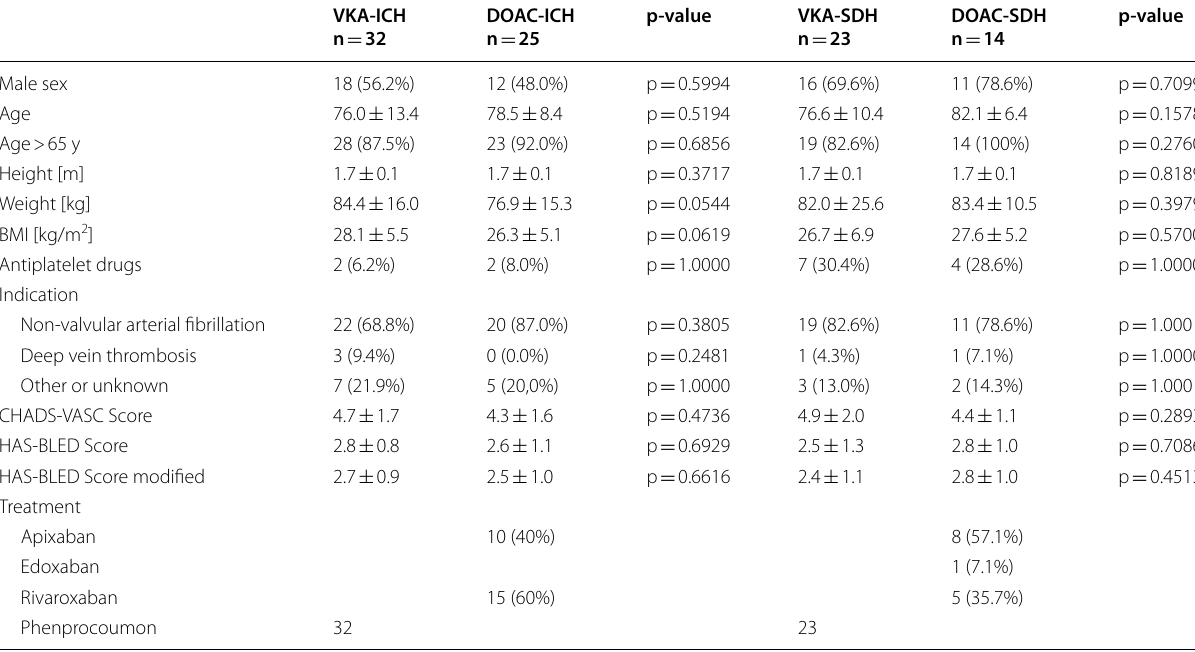
Data are presented as n (%) or mean